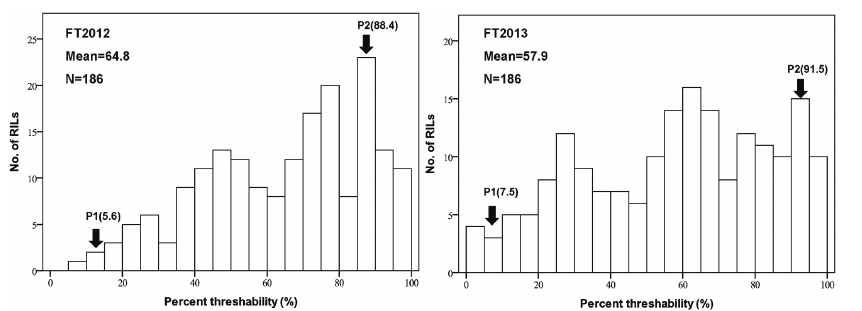
Figure 3. Frequency distributions of the percentage of completely threshed seeds from all seeds harvested. FT2012 and FT2013 were obtained from crosses between Triticum aestivum ssp. tibetanum Shao population Q1028 6 ZM9023 established in 2012 and 2013, respectively. P1: Q1028, P2: ZM9023. RILs: recombinant inbred lines. Mean: average value of the trait. N: the number of RILs.